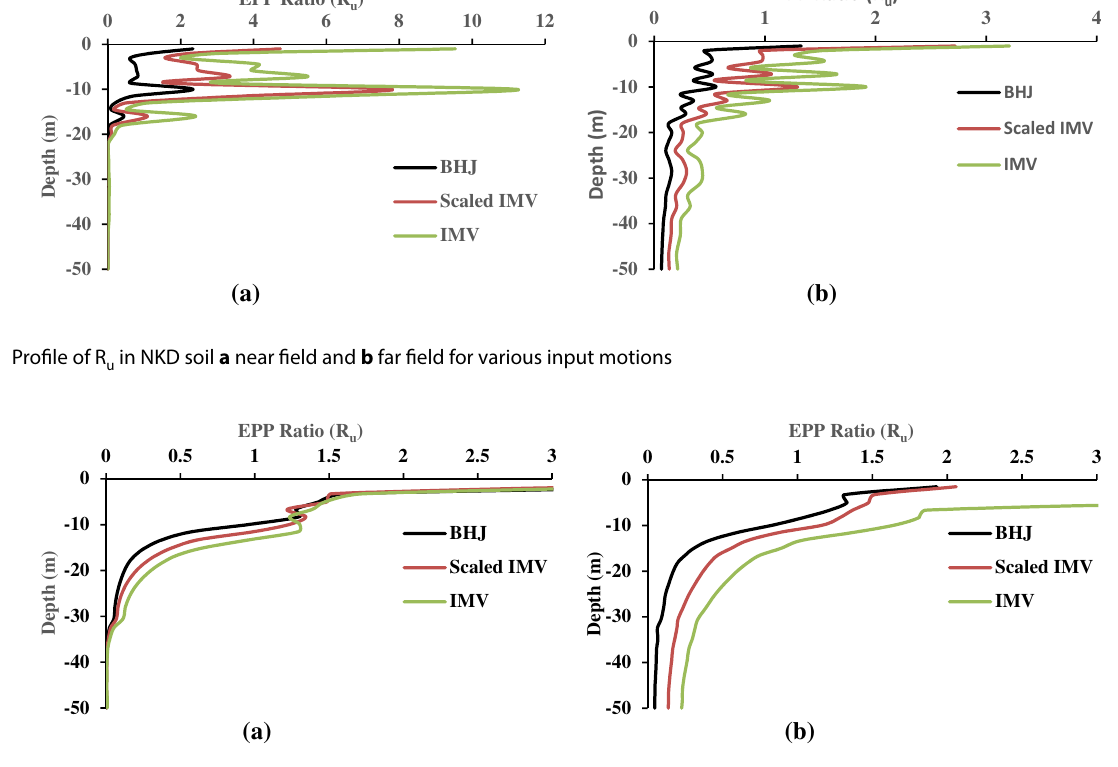
Fig. 9 Profile of R in RCD soil a near field and b far field for various input motions u